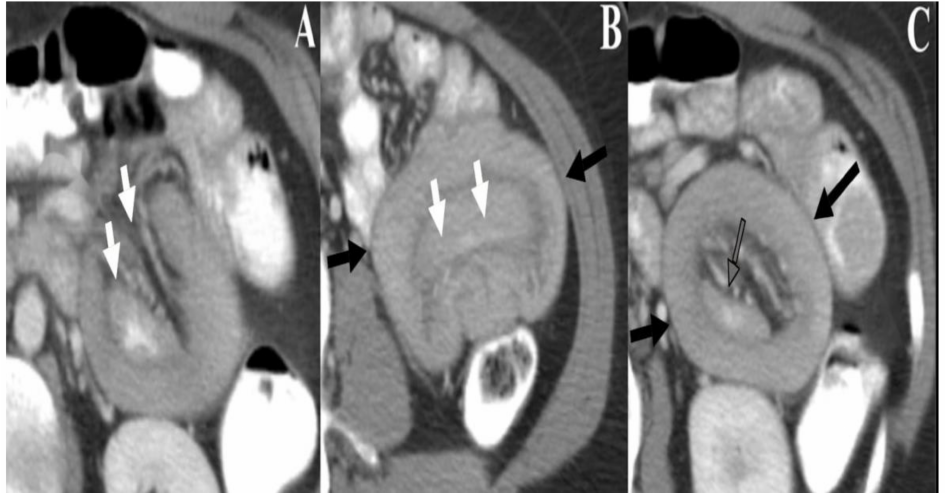
Figure 6. A 43-year-old patient with PJS and intestinal polyposis presented to the ER with abdominal pain. Axial contrast enhanced CT images of the abdomen ( Panels A – C ) demonstrate jejuno-jejunal intussusception, with telescoping of the mesenteric fat and loops of proximal jejunum (intussuscep- tum, white arrows) into the more distal jejunum (intussuscipiens, black arrow). An intestinal polyp was found to be the lead point and cause of intussusception (clear